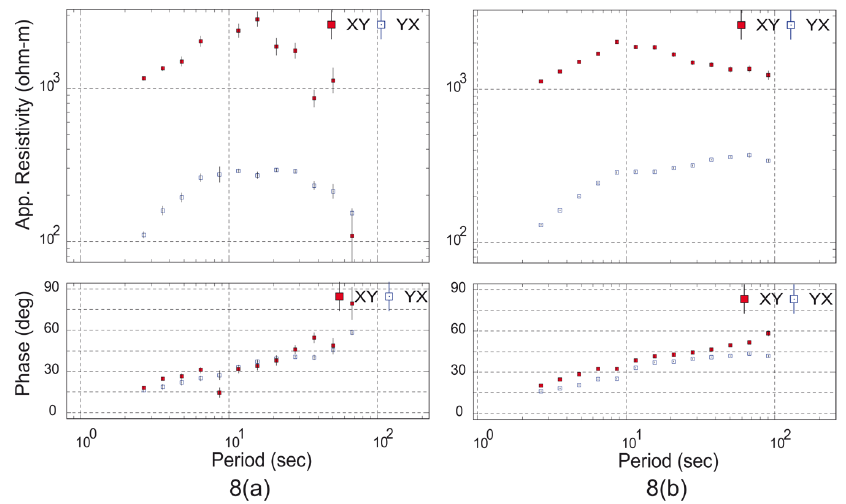
Figure 8. Effect of editing on 2 Hz data of site K11 from Koyna profile. (a) Apparent resistivity (top panel) and phase (bottom panel) curves obtained from the data before editing the time series. (b) Apparent resistivity (upper panel) and phase (lower panel) curves of the same data obtained after editing the time series provide a better outcome. The red colored boxes indicate XY components and the blue colored boxes indicate YX components of apparent resistivity and phase.